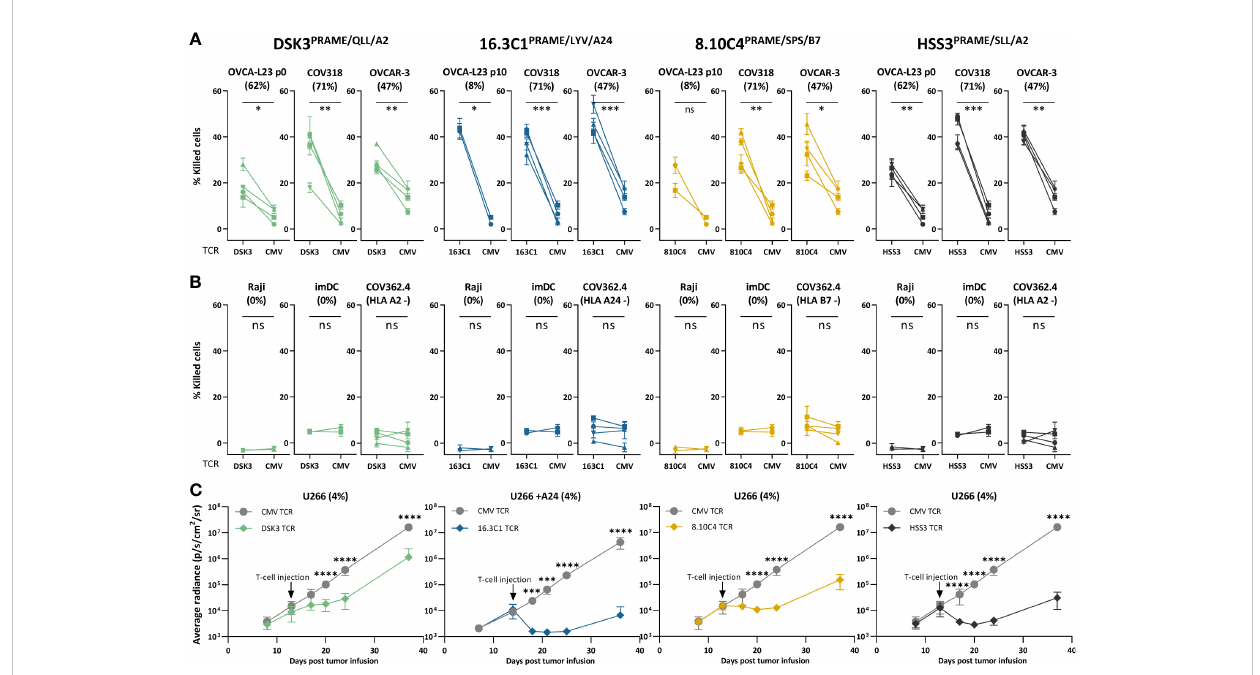
FIGURE 5 PRAME TCR-T cells kill OVCA cells in vitro and demonstrate in vivo killing potential in an established MM model. (A, B) Puri fi ed PRAME TCR-T cells were tested for cytotoxic capacity in a 6-hour 51 Cr-release assay at E:T ratio 10:1 against (A) primary OVCA patient samples and OVCA cell lines, and (B) PRAME negative cells (Raji and imDCs), or target HLA negative cells (COV362.4). Except for COV362.4, all target cells expressed the target HLA alleles, either wildtype or Td. COV318 and OVCAR-3 were Td with A24, Raji cells were Td with A2, A24 or B7. Primary malignant ascites patient sample OVCA-L23 (wildtype HLA-A2) was either passage 0 (included for TCR DSK3 and HSS3) or passage 10 Td with A24 or B7 (included for TCR 16.3C1 and 8.10C4). imDCs were isolated from PBMCs of a A2+, A24+ and B7+ donor. Percentage relative PRAME expression is depicted, as determined by qPCR. Cytotoxic capacity of PRAME TCR- and CMV TCR-T cells were compared using a paired t-test (two-sided). Mean and SD of technical triplicates are depicted for four donors tested in two independent experiments. (C) NSG mice engrafted with 2*10 6 U266 MM cells Td with Luc2 luciferase. Mice were i.v. treated with 5*10 6 PRAME or CMV TCR-T cells 14 days after tumor infusion. Mean and SD of tumor outgrowth (average radiance measured by bioluminescence imaging) over time on the ventral side are depicted. N=6 for PRAME TCR-T cells and n=4 for CMV TCR-T cells. Tumor outgrowth in mice treated with PRAME or CMV-TCR T cells was compared for each time point using two-way ANOVA on log- transformed data, followed by Bonferroni post-hoc analysis. Only signi fi cant results are depicted. (ANOVA, analysis of variance, E:T, effector:target ratio; ns, not signi fi cant; imDCs, immature dendritic cells; MM, multiple myeloma; OVCA, primary ovarian carcinoma sample; Td, transduced). Meaning of the * are listed in the M&M. Signi fi cance levels are indicated as p <.05 *, p <.01 **, p <.001 ***, and p <.0001 ****. ns, not signi fi